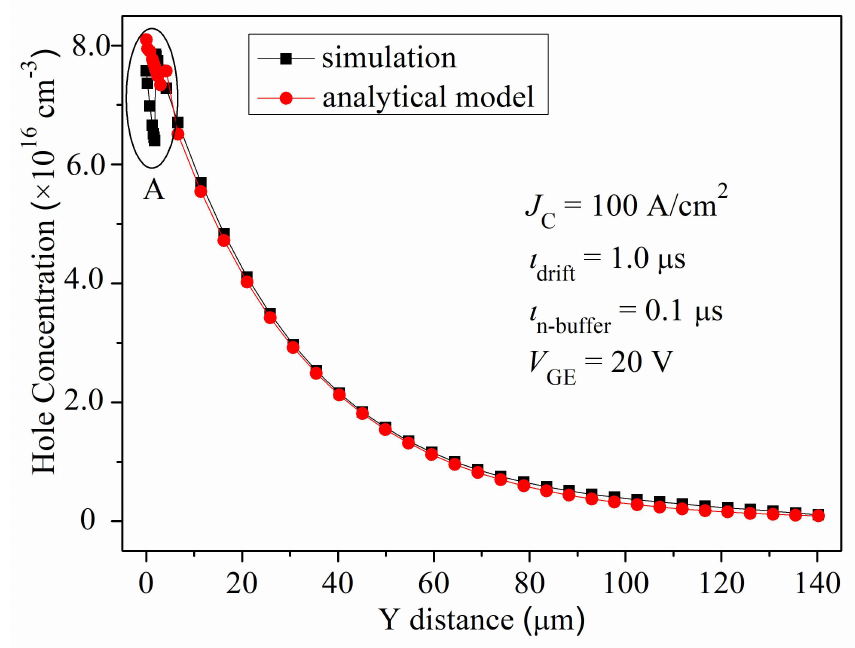
Figure 3. Hole-carrier concentration profile in buffer and drift